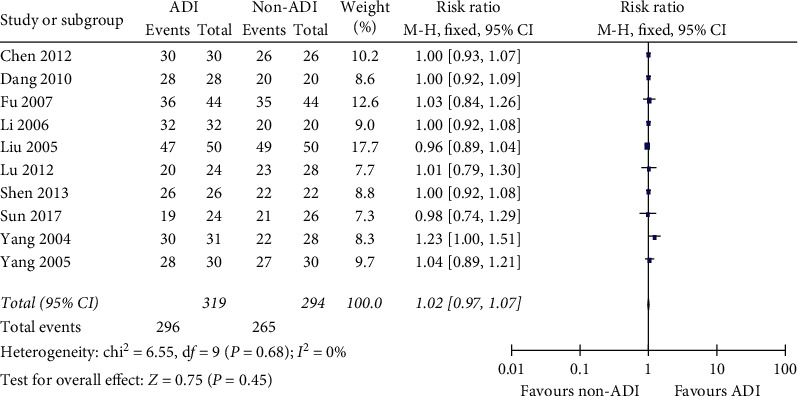
ADI did not improve DCR in advanced BC patients as an add-on therapy (RR = 1.02, 95% CI 0.97–1.07; chi2 = 6.55, P=0.68; I2 = 0%).